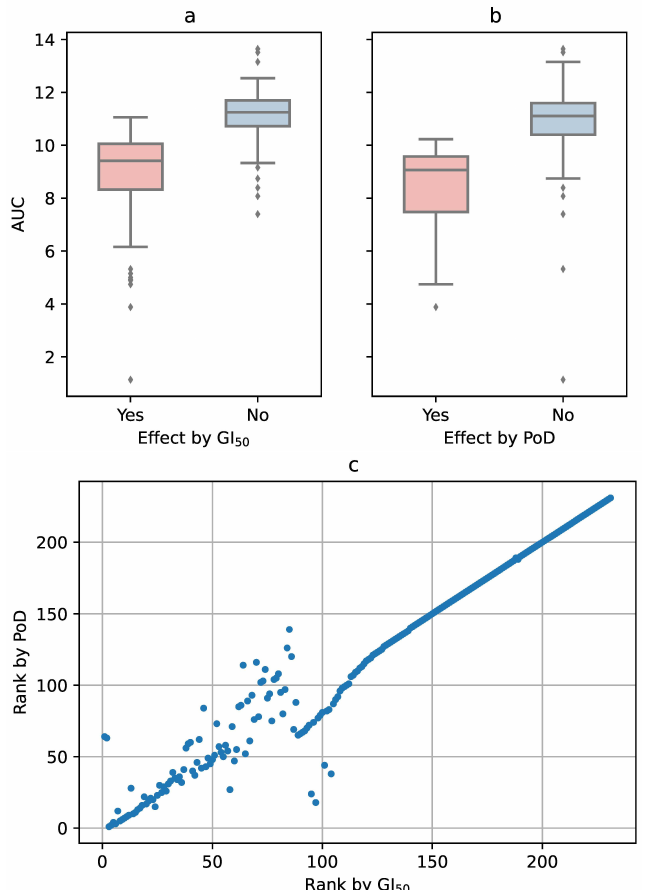
Figure 6. ( a ) If a drug failed to reach GI 50 , the AUC had a significantly higher value. ( b ) The same behavior, only with slightly lower AUC values, was observed when using PoD as the criterion for the effect. ( c ) Correlation between the rankings by GI 50 and by PoD. For the top 20 substances (lower left corner in the figure), there is little difference between the two